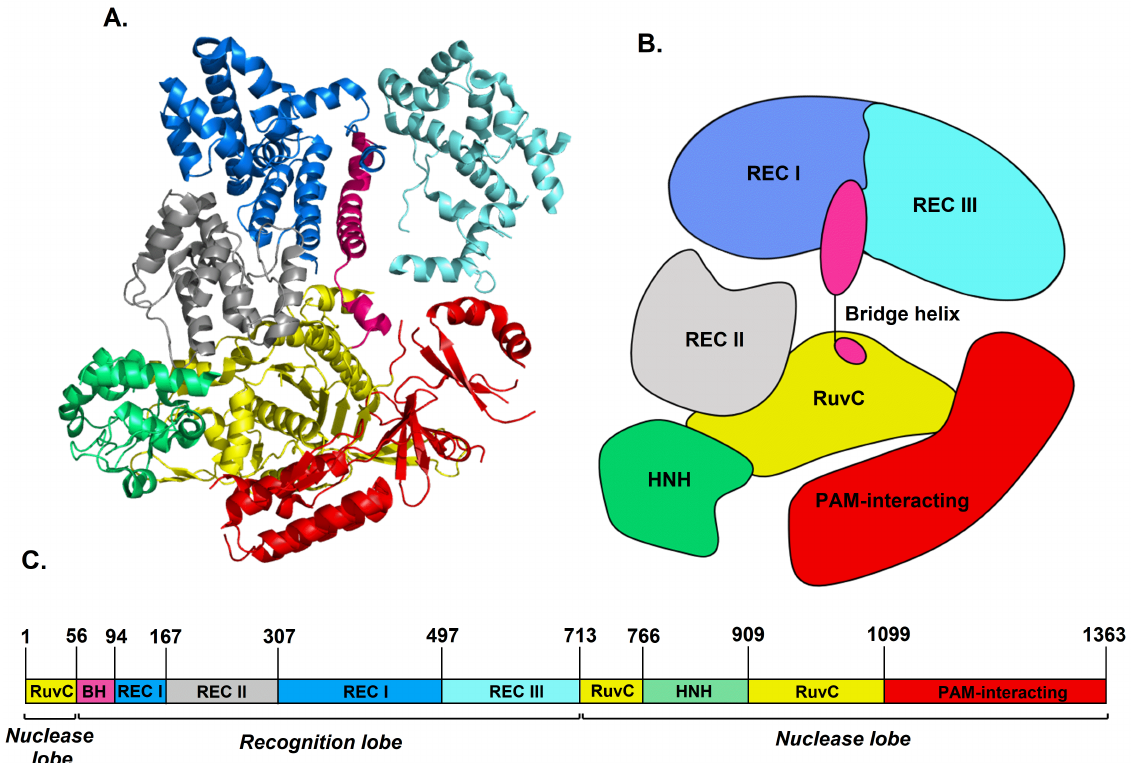
Figure 2. The structure of Streptococcus pyogenes Cas9 protein, which contains seven domains: Rec I, Rec II, REC III, Bridge Helix, RuvC, HNH, and PAM-interacting. Domains are presented in crystal ( A ), schematic ( B ), and map ( C ) form. Crystal image was rendered from RCSB PDB ID: 4CMP [19], using PyMOL software (Schrödinger Inc., New York, NY,